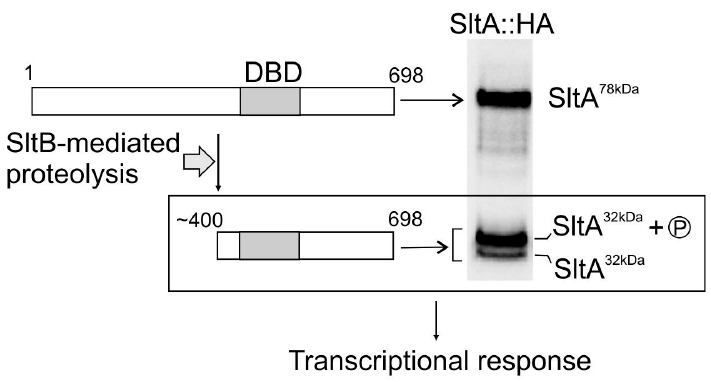
Figure 1. Proteolytic processing of SltA in Aspergillus nidulans . The full-length SltA78kDa form is proteolytically cleaved by SltB to render a truncated, active form of 32 kDa (SltA32kDa). This form comprises the DNA-binding domain (DBD) plus the poorly conserved C-terminal region, and is phosphorylated (low mobility SltA32kDa band). Shown is an immunodetection of SltA forms tagged at the C-terminus with three copies of the hemagglutinin (HA) tag, SltA::HA for brevity. Modified from [6].